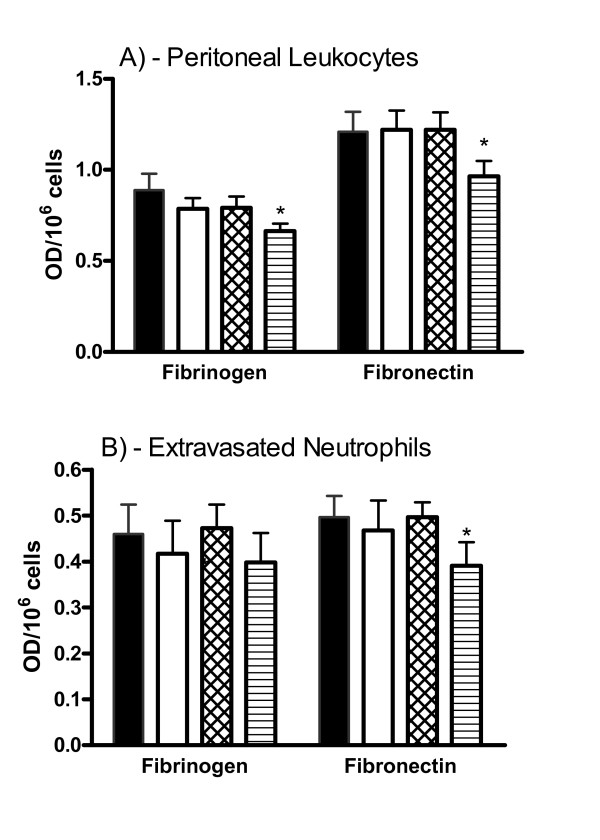
PAF is required for inhibition of adhesion by feG. The inclusion of PAF (10-9M) was required to observe an inhibitory effect of feG (10-11M) on the adhesion of peritoneal leukocytes from unsensitized animals to fibrinogen and fibronectin. With extravasated neutrophils feG inhibition of adhesion only occurred in the presence of PAF for fibronectin. Control (black column), feG (open column; 10-11M), PAF (crossed column), and PAF + feG (lined column). Mean ± SEM; p < 0.05; * = less than corresponding controls; n ≥ 4 for each group of cells and substrate.